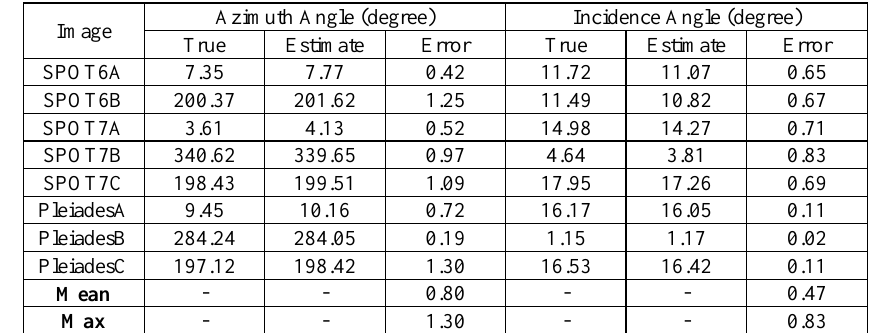
Table 3. The results of satellite imaging direction angle